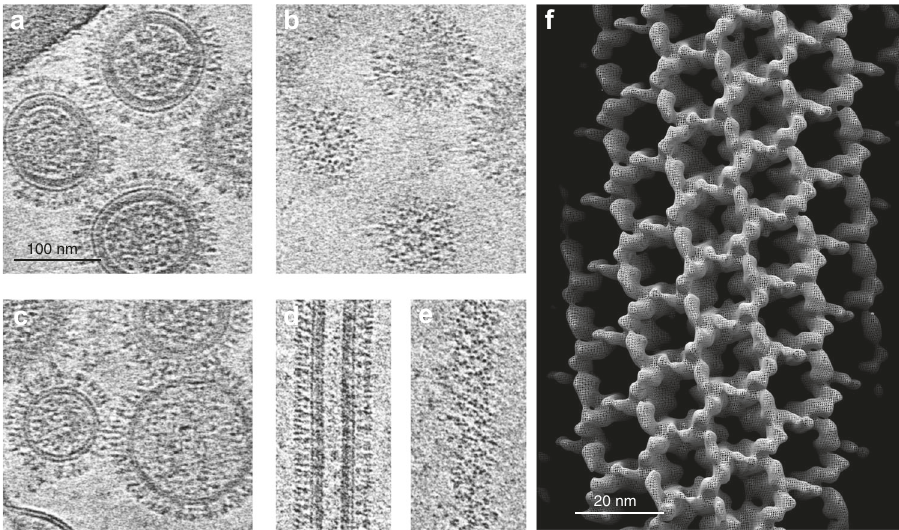
Fig. 1 Electron cryotomography of in fl uenza C virus. a A central section through spherical virions with a matrix layer. Visible are the outer glycoprotein layer on the virus surface, the electron-dense matrix layer that appears continuous with the inner membrane lea fl et, and ribonucleoprotein particles (RNPs) in the interior. b The same virions as in panel a in a tomogram section showing the hexagonal organization of the glycoprotein layer on the virus surface. c A central section through particles lacking a matrix layer. The glycoprotein layer is visible but the matrix layer is absent beneath the bilayer and the interior is less electron-dense and lacks compact RNPs. These particles also exemplify the size variation in the particles without a matrix layer (See also Supplementary Fig. 2). d , e A fi lamentous particle is shown in a central section ( d ) or a section through the surface ( e ) showing the hexagonal organization of the glycoprotein layer. Each image in a-e shows a sum of 20 tomogram slices corresponding to a projected volume ~9 nm thick and are at the same scale. Tomograms were recorded (as described in Supplementary Table 1) from a single preparation of the virus. f Helical reconstruction from 2D images of a single fi lamentous virion at 32 Å resolution. The ~76 nm thick fi lament shows the hexagonal lattice covering the